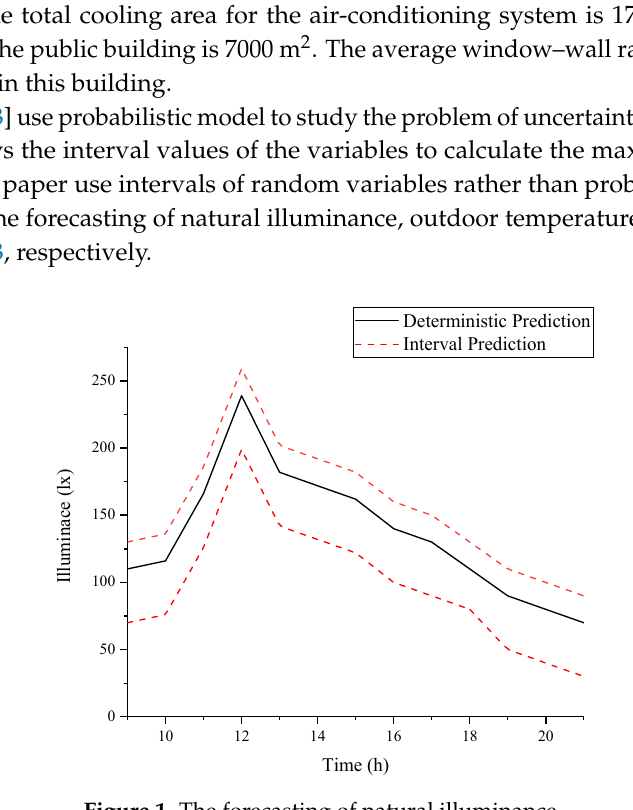
Figure 1. The forecasting of natural illuminance.